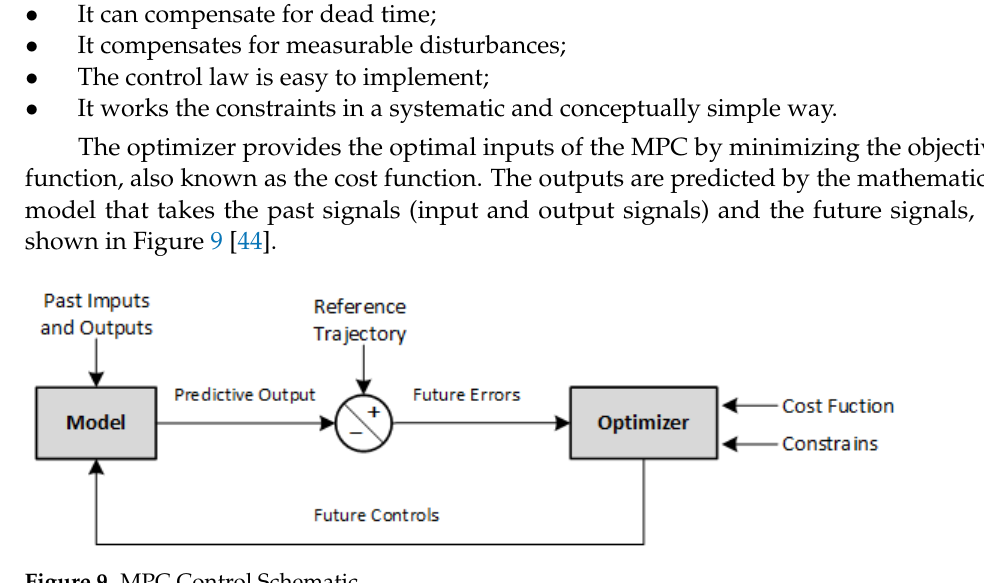
Figure 9. MPC Control Schematic.